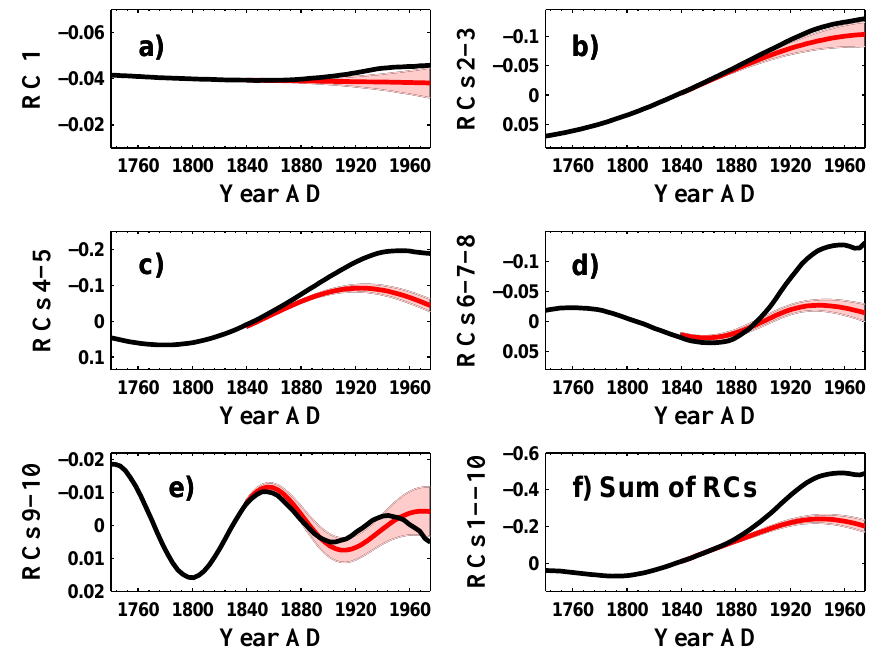
Fig. 5. Prediction results for the LFV portion of the δ 18 O time series during the Industrial Era, taken here as 1840–1979 AD; the low-pass filtered observations y LF are shown back to roughly 1740 AD to give a better feeling for the range of natural variability. (a) – (e) Results for individual narrow-band signals: (a) the trend given by RC1; (b) – (e) oscillatory signals given by RCs 2–3, 4–5, 6–8 and 9–10, respectively; (f) result for the sum of the ten leading RCs, 1–10. Black curves: observed narrow-band signals extracted from the total δ 18 O series; red curves: forecast obtained by the AR approach, accompanied by pink shading giving the forecast uncertainty, based on the performance R = R(L) of the individual narrow-band-signal forecasts over the testing section (see text for details).